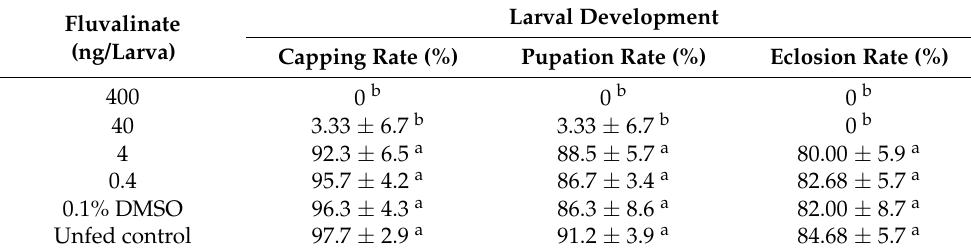
Table 1. Effects of consecutive 4-day feeding of fluvalinate on 1-day-old